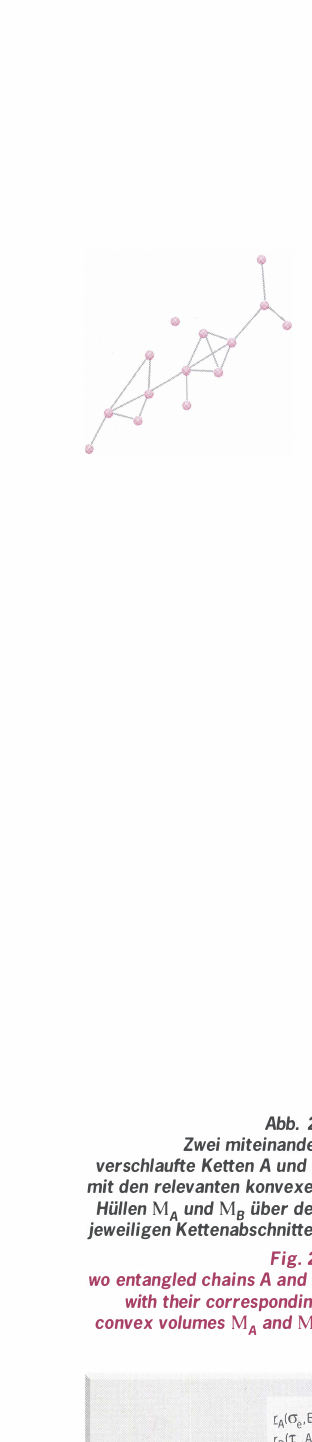
Fig. 2: wo entangled chains A and B with their corresponding convex volumes M A and M8